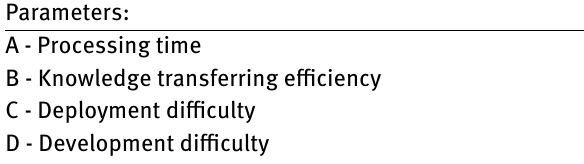
Figure 1: Learning eflciency pyramid [9]. Table 1: Parameters for decision